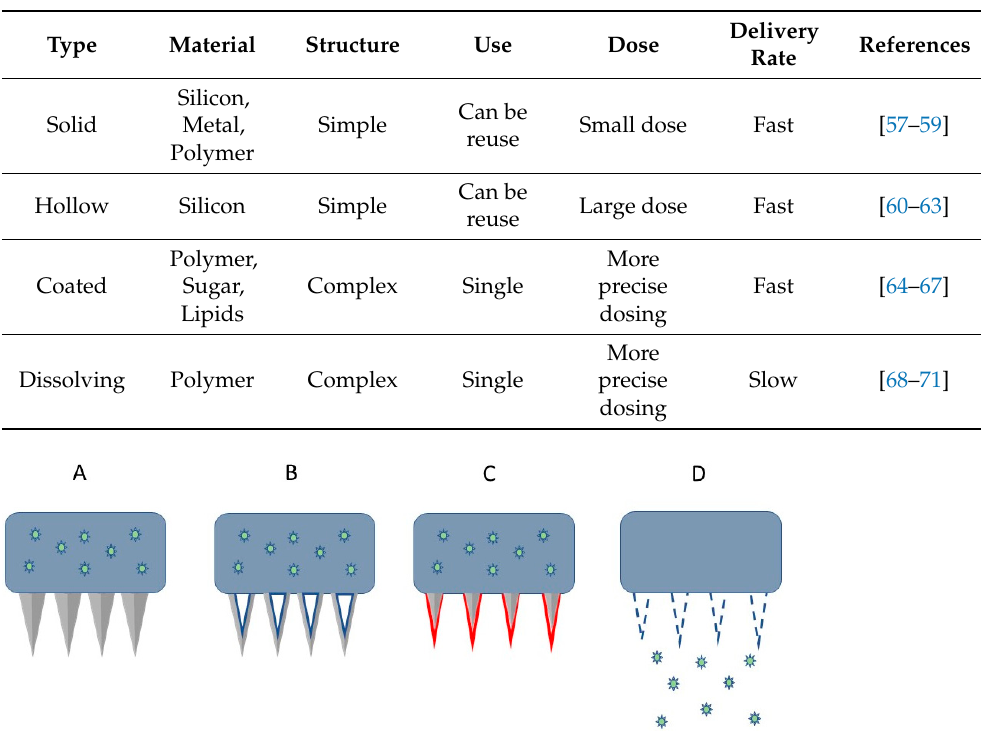
Figure 3. The microneedle-based patch: ( A ) solid; ( B ) hollow; ( C ) coated; ( D )